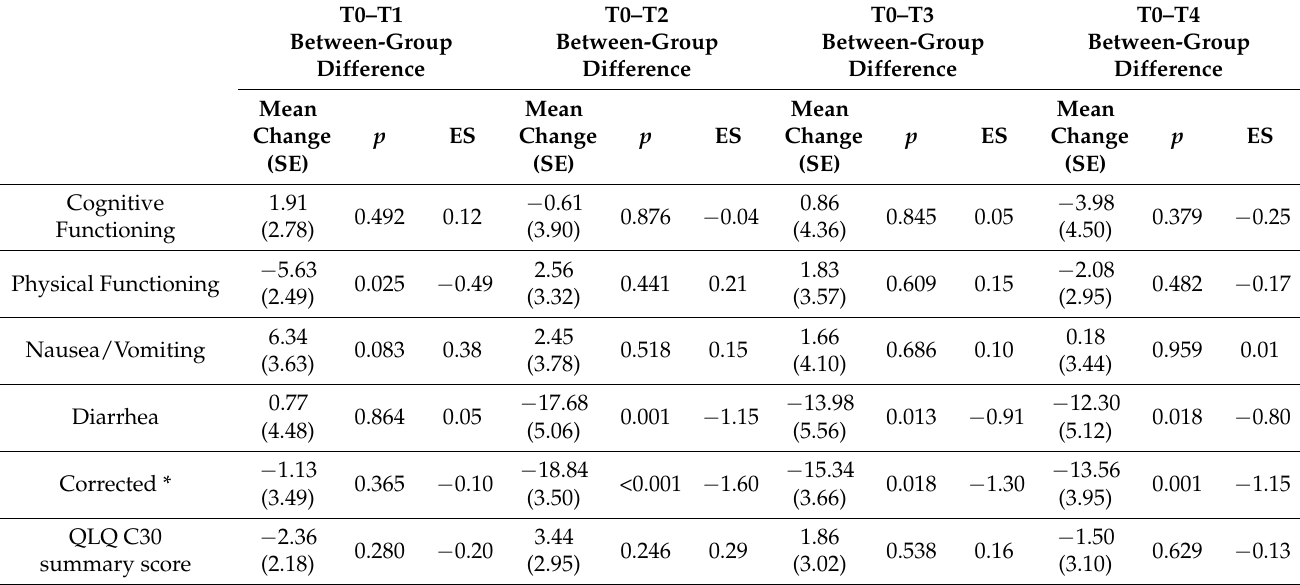
Table 5. Quality of Life. Mean changes in mean and effect sizes. SE = standard error. ES = effect